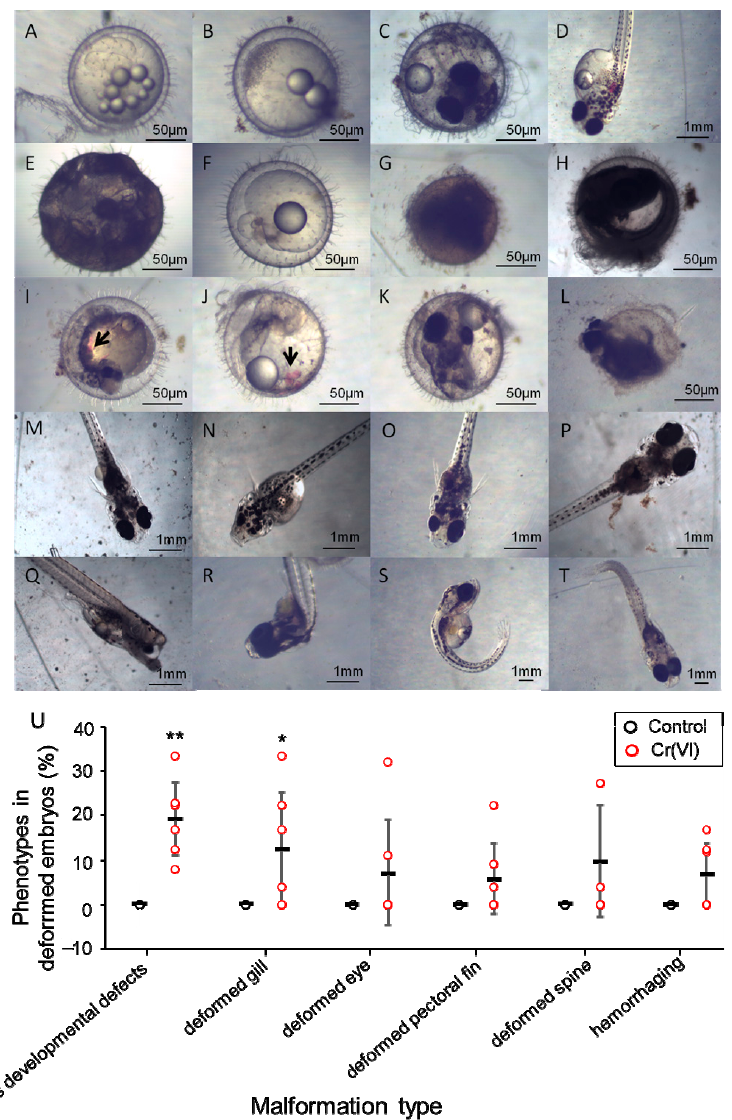
Figure 5. Abnormalities in F1 generation of marine medaka with Cr(VI) exposure. ( A – D ) Normal embryo and larvae; ( E ) seriously stained unfertilized egg; ( F ) embryo with abnormal blastoderm; ( G ) stained embryo; ( H ) dead embryo; ( I ) embryo with gross developmental defects and hemorrhaging; ( J ) eyeless embryo and hemorrhaging; ( K ) embryo with abnormally shaped eye; ( L ) embryo hatched unsuccessfully; ( M ) larvae with small yolk sac; ( N ) deformed larvae with abnormally shaped eye and single pectoral fin; ( O ) deformed larvae with abnormally shaped eye;( P ) deformed larvae without pectoral fin; ( Q ) deformed larvae with abnormal head; ( R – T ), deformed larvae with curled spine); Arrowheads, hemorrhaging; ( U ) the malformation rate of common malformations; **, p ≤ 0.01; *, p ≤ 0.05. The number of biological samples used for each group is as follow: con-con ( N = 486), con-cr ( N = 81), cr1-con ( N = 145), cr1-cr ( N = 159), cr2-con ( N = 90), cr2-cr ( N = 87). The number of biological samples used for each group is as follow: con ( N = 652), cr ( N = 746).